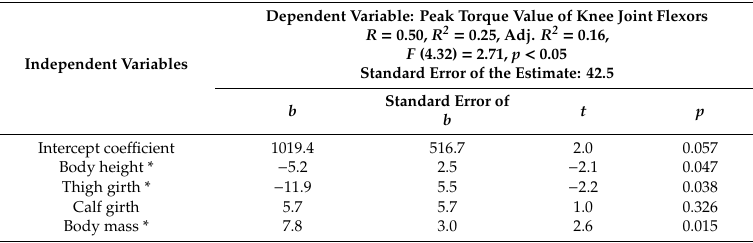
Table 5. Results of regression analysis for knee joint flexor